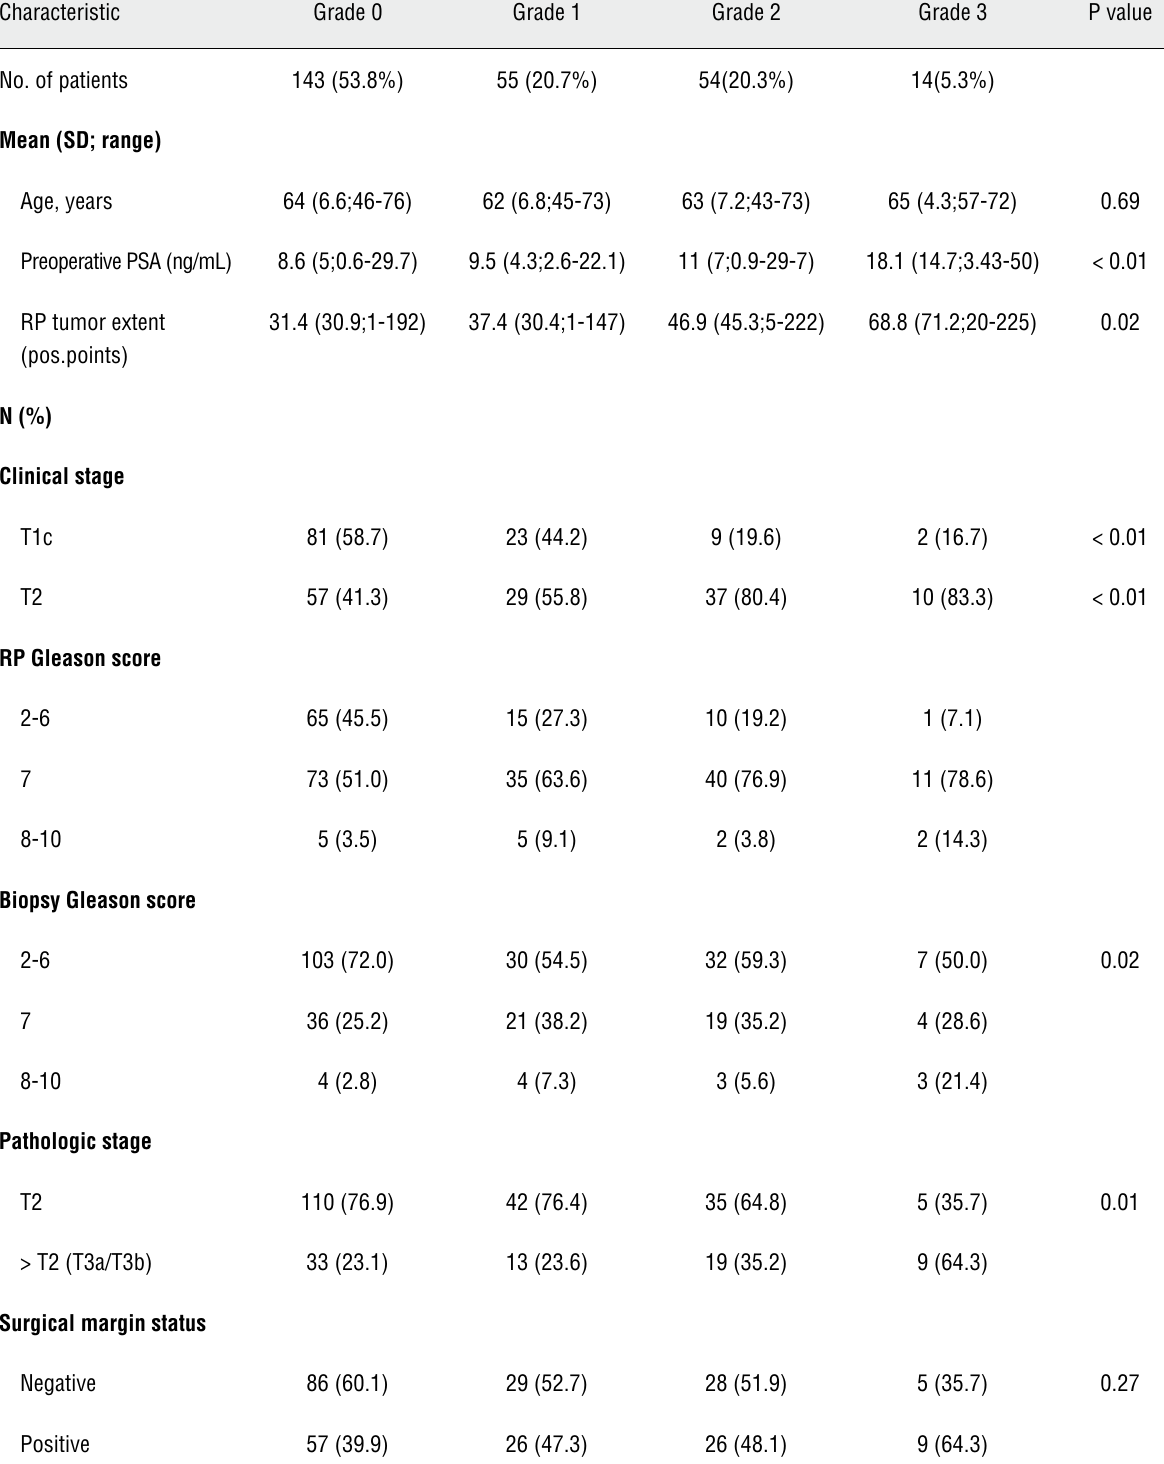
Table 1 - Clinicopathologic characteristics of 266 patients undergoing radical prostatectomy according to biopsy reactive stroma